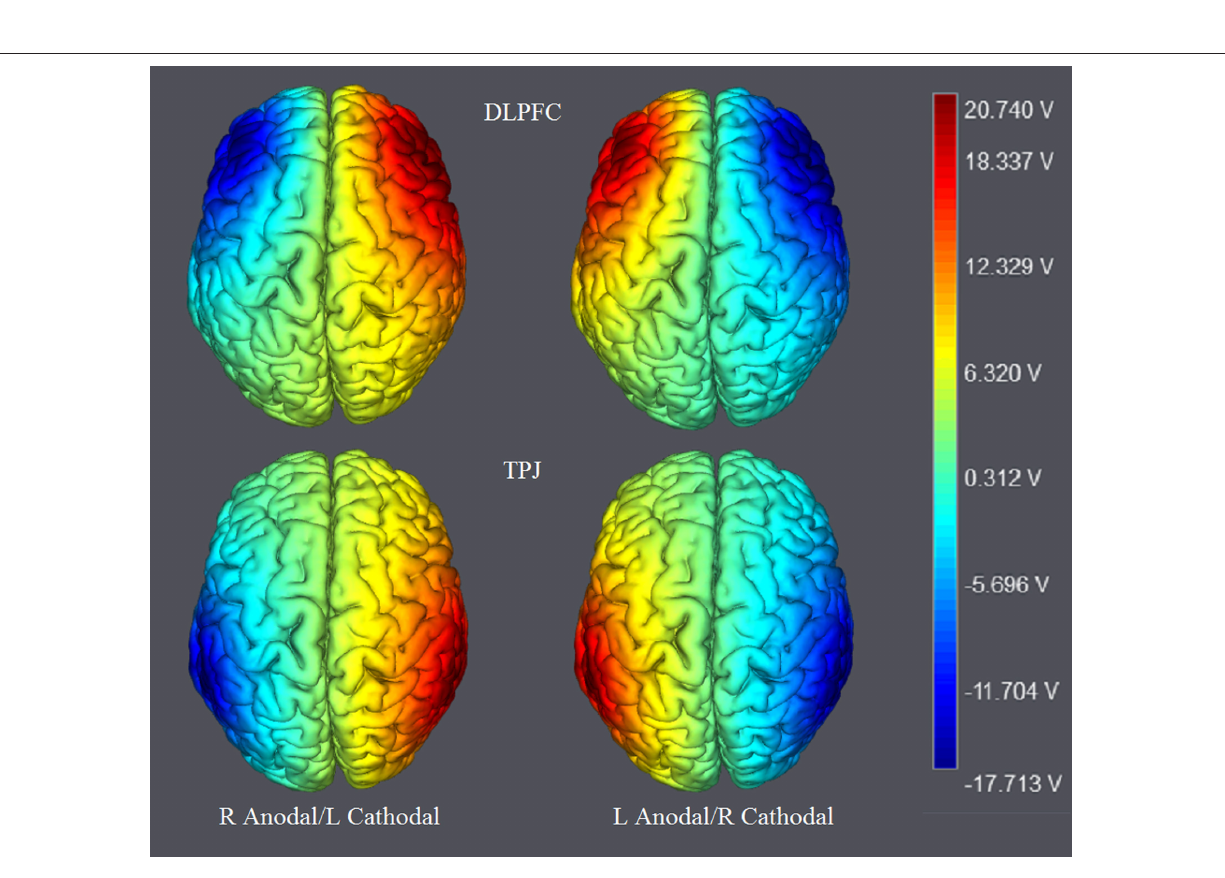
Frontiers in Neuroscience | www.frontiersin.org